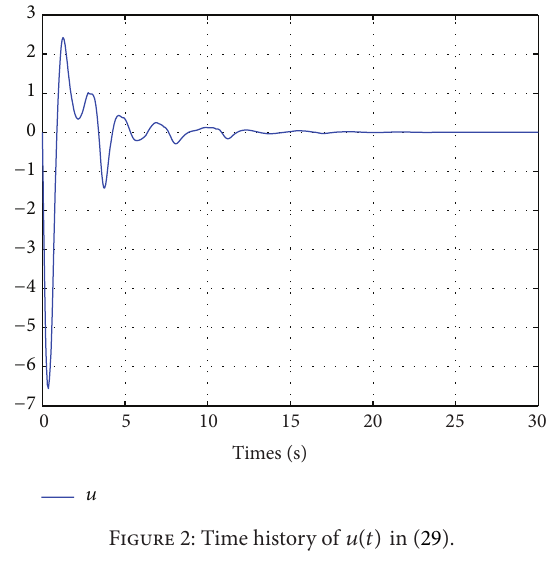
Figure 2: Time history of 𝑢(𝑡) in